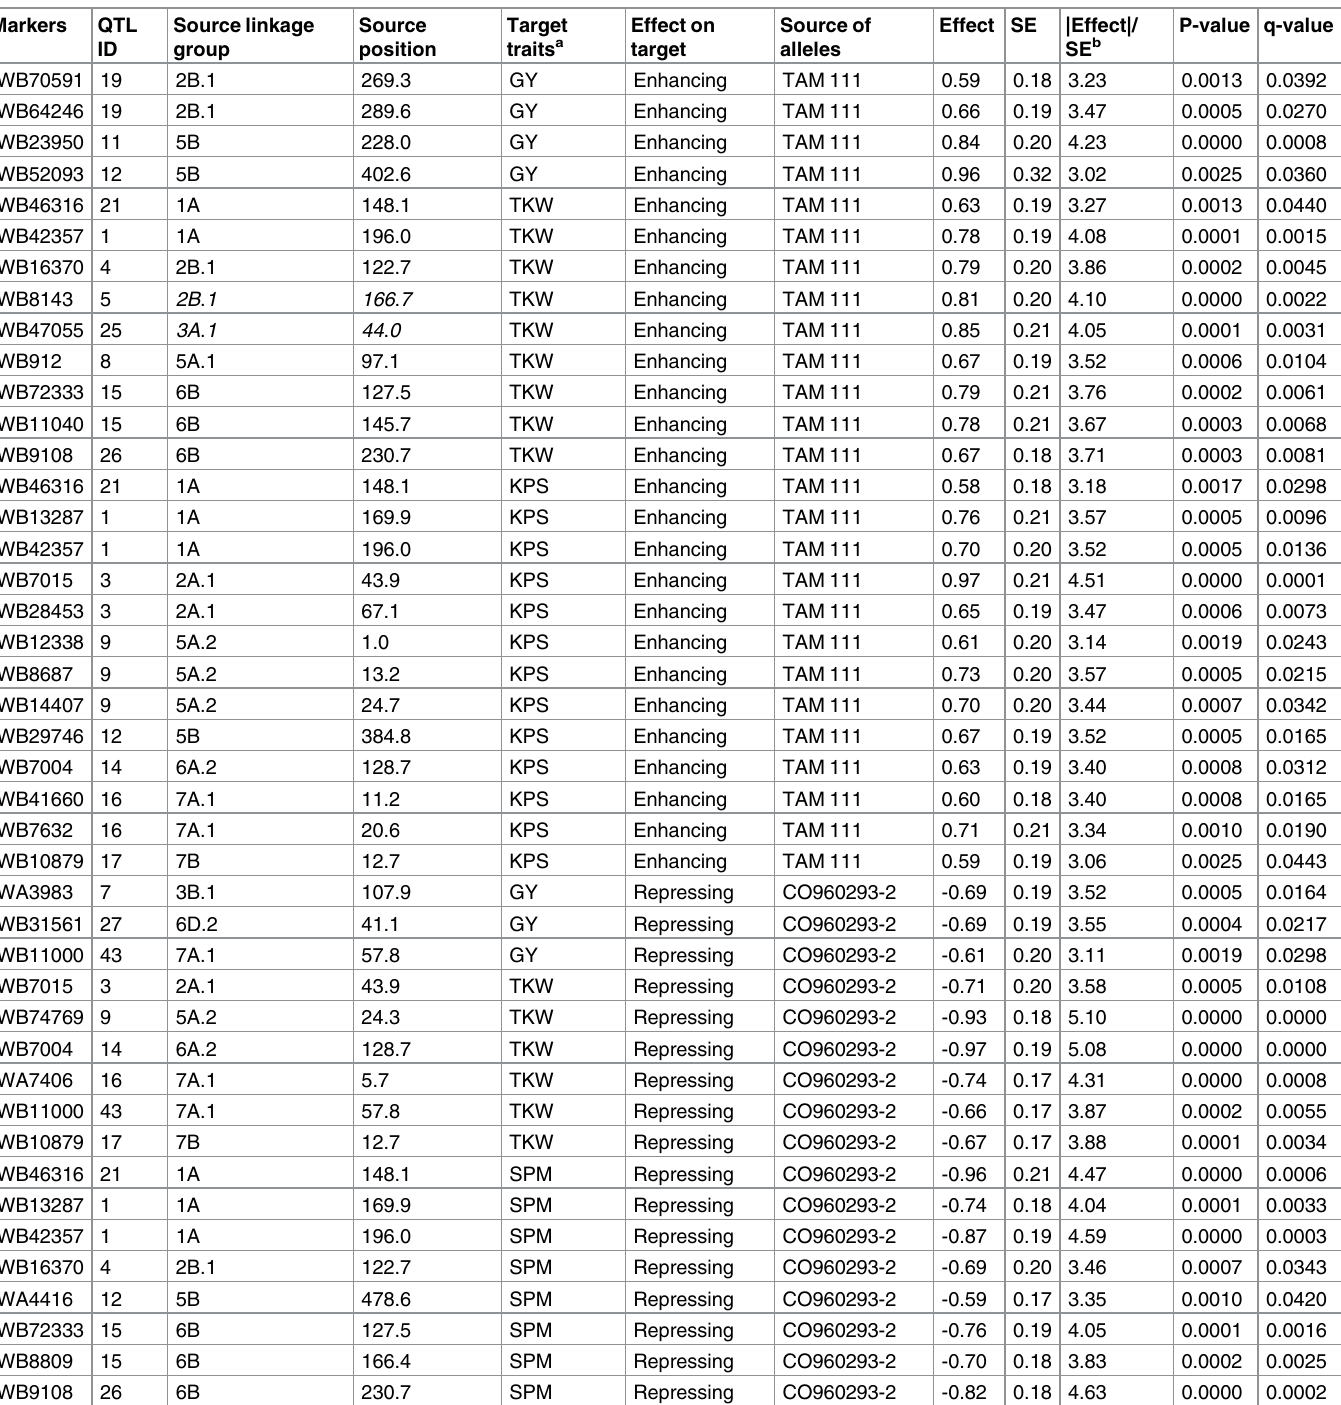
Table 3. Significant marker-to-trait influences based on a subset of markers in combined analysis of pleiotropy and